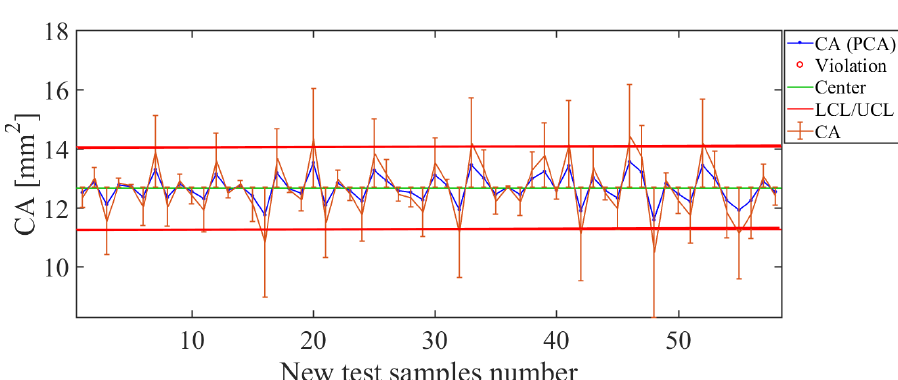
Figure 17. Soft-sensor response (control chart and error bars) for the CA descriptor. The best estimation levels are obtained in the range 10 mm 2 < CA < 15 mm 2 .